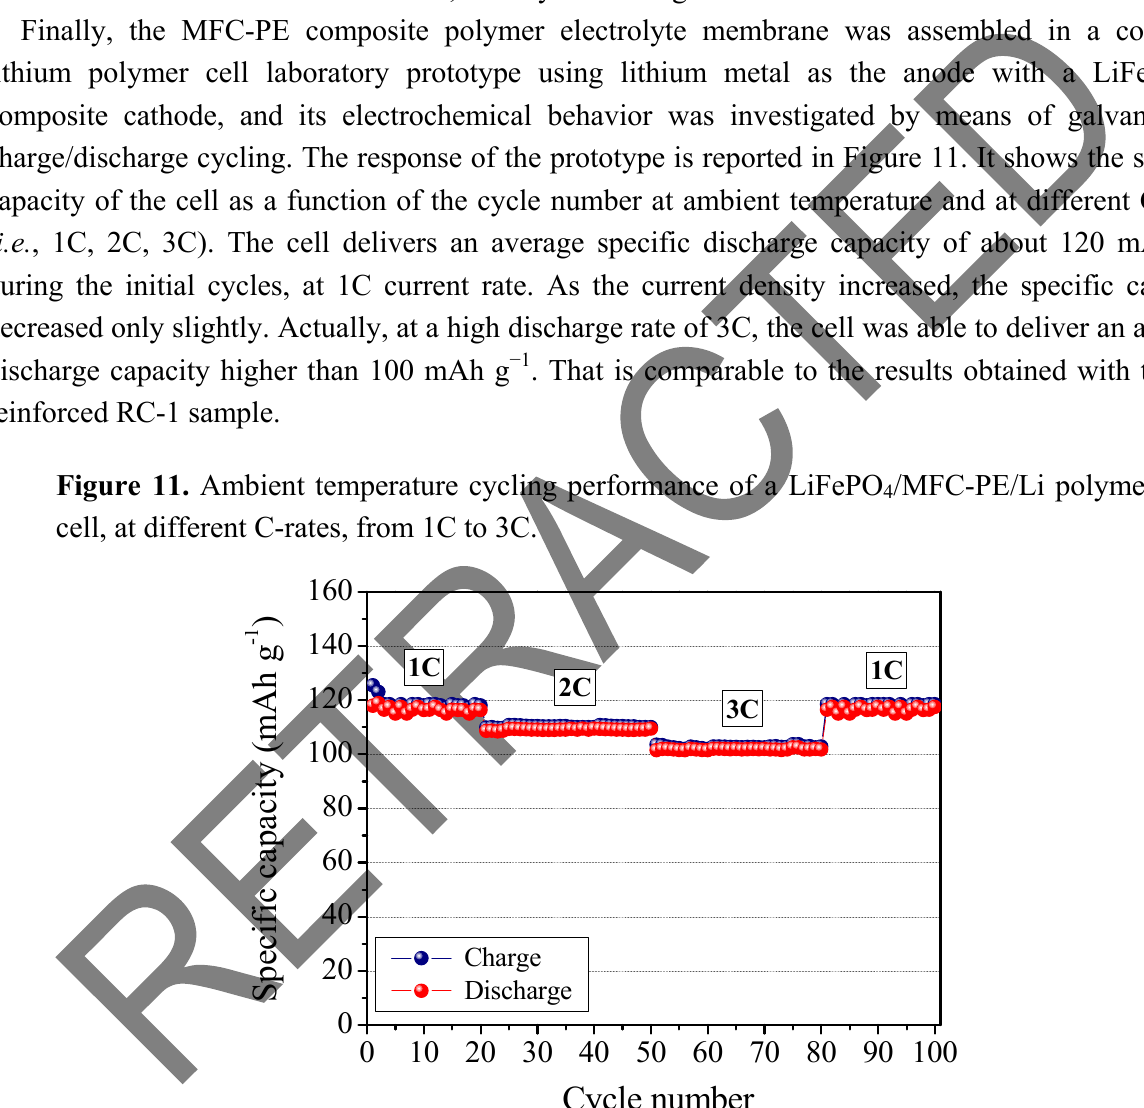
/MFC-PE/Li polymer 4